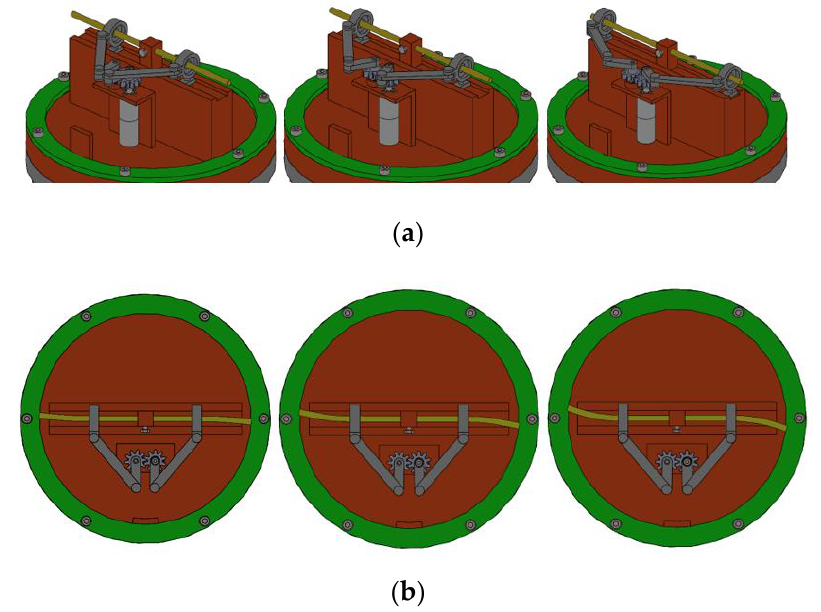
Figure 2. Schematic diagram of crank slider movement and spring bar bending. ( a ) Different positions of the sliding clamp. ( b ) Bending diagram of spring bar.